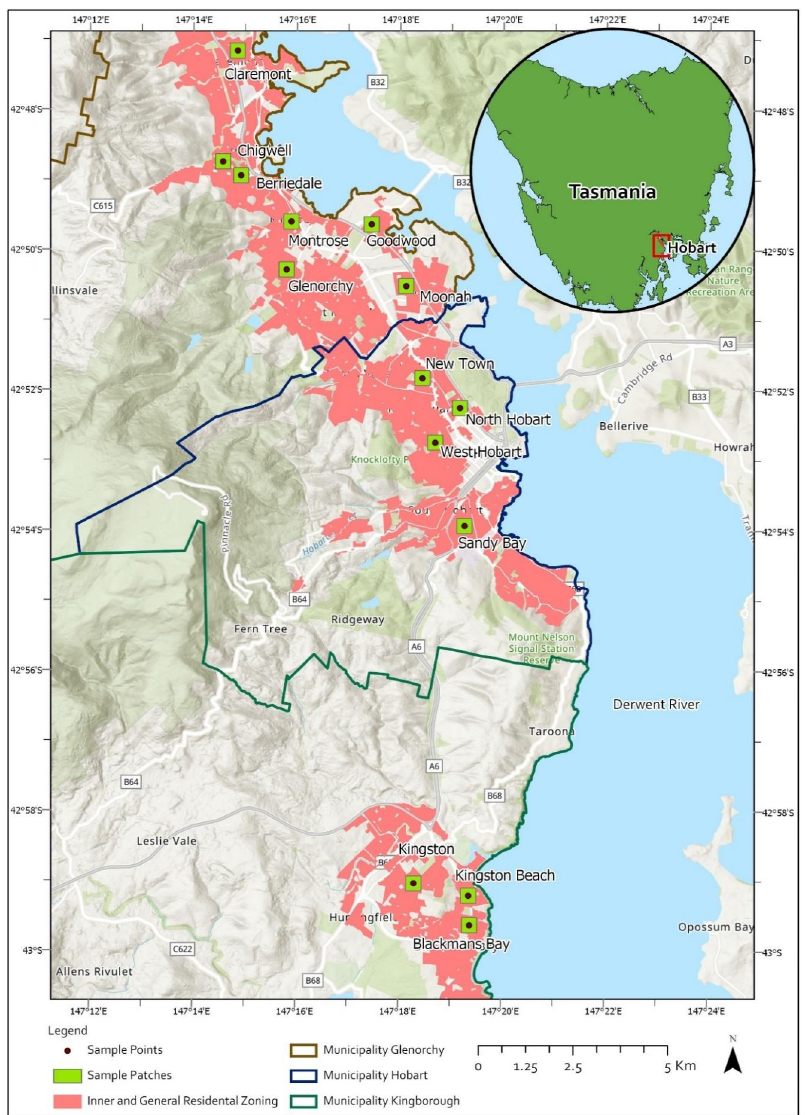
Figure 1. Hobart inner and general residential zoning with fourteen random sample points and patches of four hectares (seven sample points/patches in Glenorchy Municipality, four in Hobart Municipality and three in Kingborough Municipality).